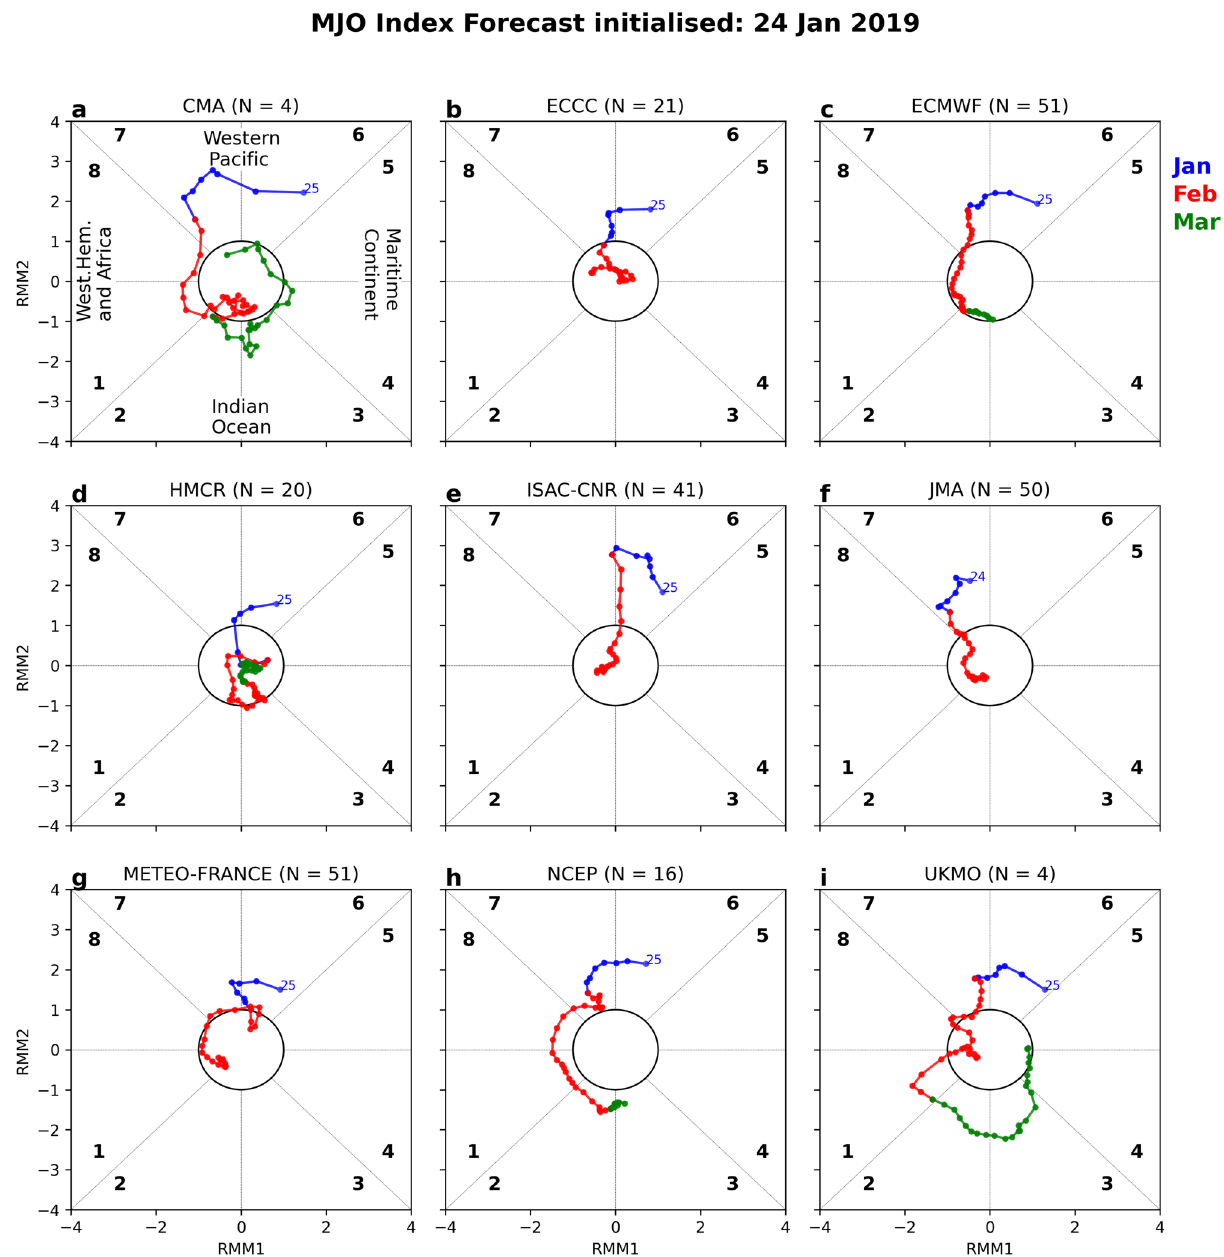
Figure 5. Time evolution of multi-member ensemble MJO predictions for nine S2S models, initialised on 24 January 2019 (lead week 1 forecast). Shown are the evolutions from late January (blue) through February (red) into March (green) for ( a ) CMA, ( b ) ECCC, ( c ) ECMWF, ( d ) HMCR, ( e ) ISAC-CNR, ( f ) JMA, ( g ) Météo- France (CNRM), ( h ) NCEP and ( i ) UKMO. Note, JMA is initialised on 23 January, hence its first date is 24 January. Despite not all the MJO forecasts extending to March, all cover the early February flood event. The observed MJO trajectory is shown in Suppl. Fig. NCEP (Fig. 5g,h, respectively). This infers that some of the models were able to partly capture the increase in MJO residence time over the western Pacific. One possibility is that a small subset of model members predicted the stalling MJO, however by averaging over larger ensembles, this acted to smooth out the signal. To test this, we repeated the analysis, only focusing on ensemble member forecasts where the livestock chill forecast exceeded the 90th percentile hindcast values in more than 60% of the inland Gulf region. The results show that the major- ity of these model ensembles do not show a more well-defined stalling structure in their MJO phase diagrams associated with the extreme chill conditions (i.e., one that is clearly different from using all model members), except for NCEP where there is a noteworthy stalling in the MJO evolution from phases 7 to 6 and back to 7 in the first 10 days of February (Suppl. Fig. 6e).